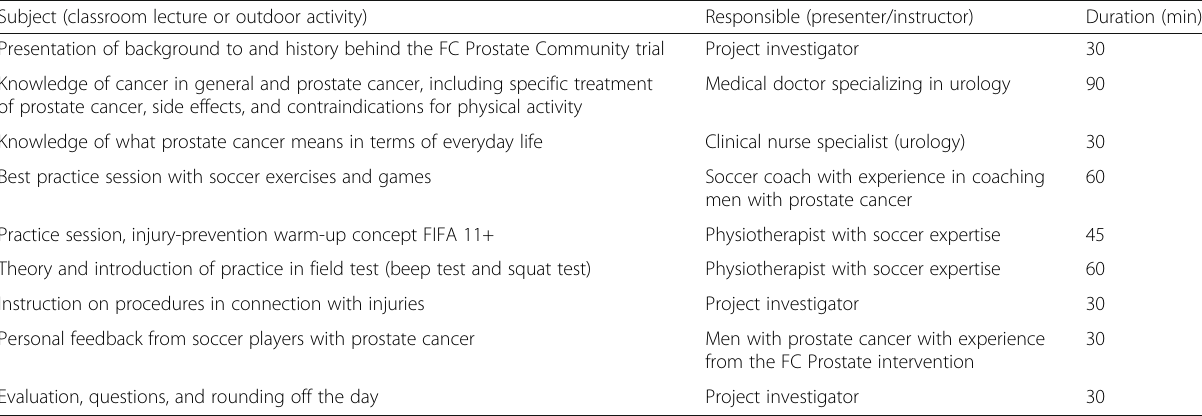
Table 5 Final template and structure of the 1-day FCPC training course Subject (classroom lecture or outdoor